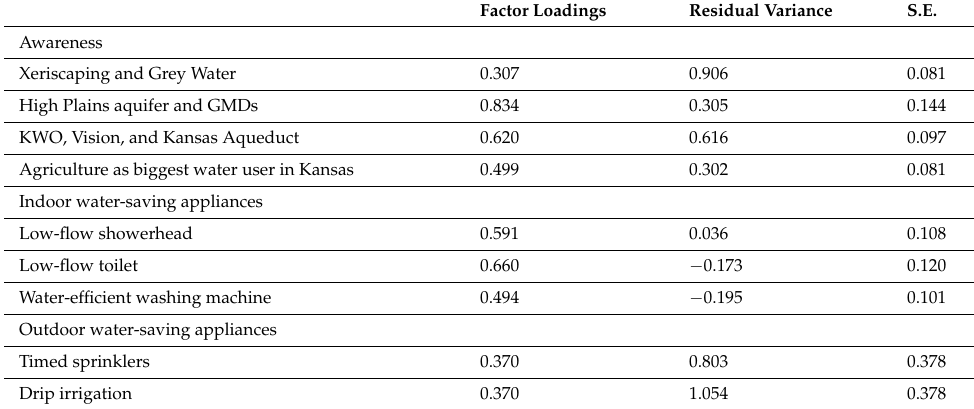
Table A8. Standardized model results of owning water-saving appliances for appliances for indoor and outdoor usage regressed on awareness levels for feedlot well owners (n =